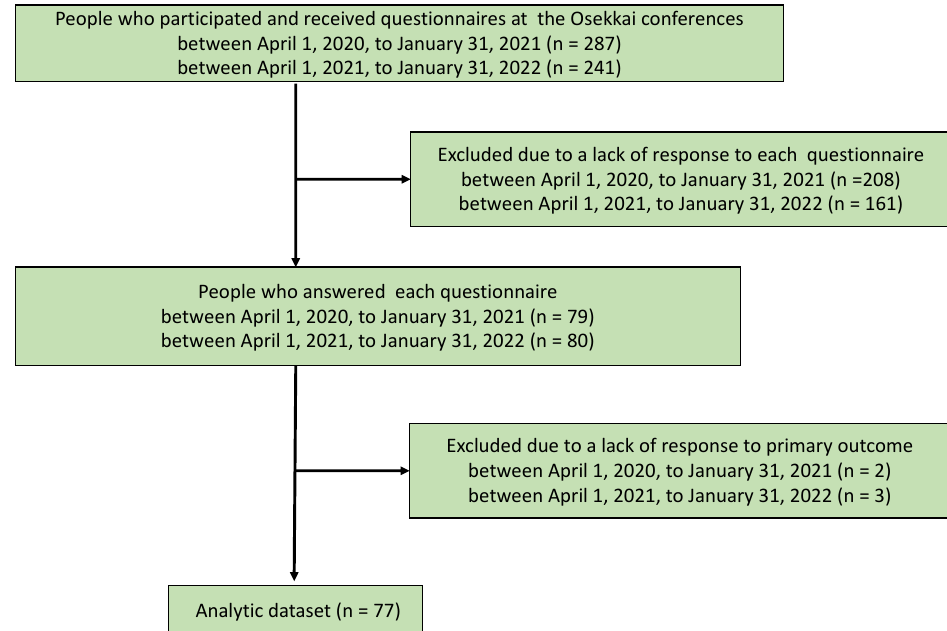
Figure 2. Flow chart of the participants’ selection .